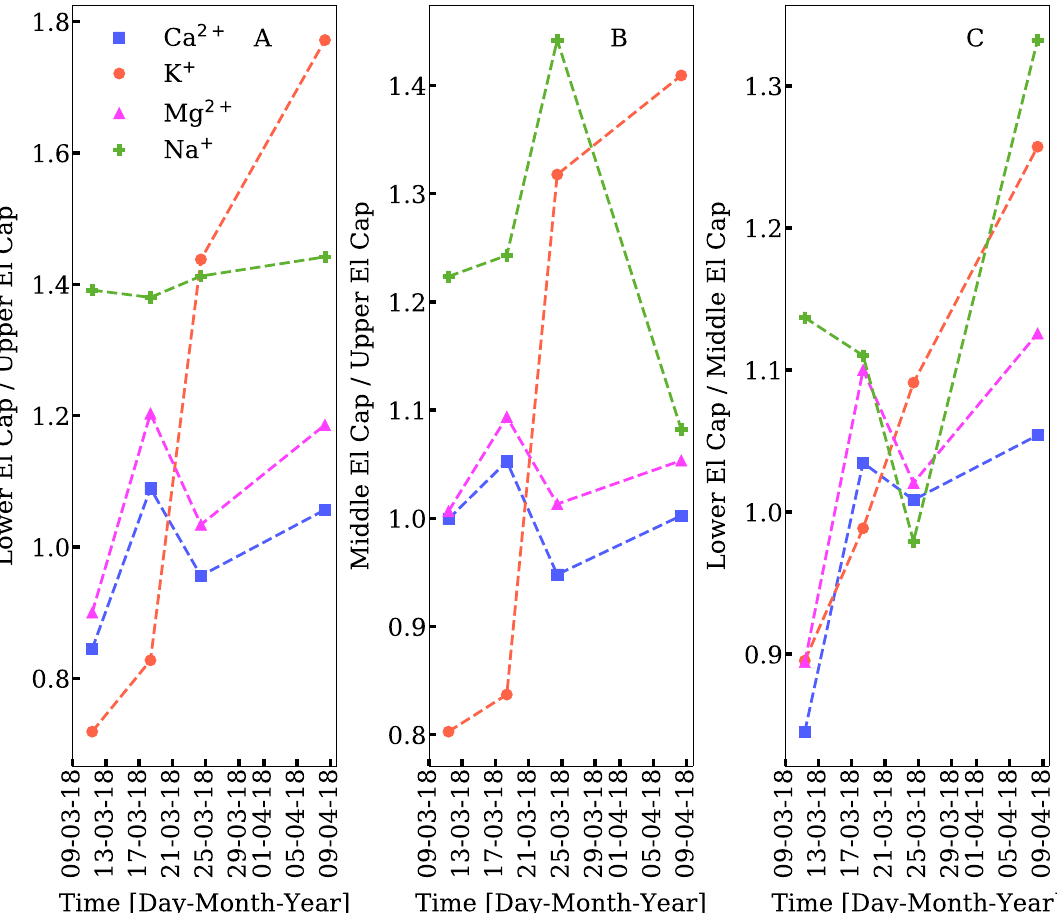
Figure 6. Comparison of major cation concentrations between downstream and upstream sites for dates (day-month-year) following the second storm (11 March 2018). Each plot illustrates same-day downstream/upstream concentration ratios for a pair of sites. The results show how concentrations of major cations changed proportionally over time (y-value > 1 implies higher concentrations downstream; <1 implies lower concentrations downstream; = 1 implies no change). ( A ) Concentrations in the Lower El Cap site compared to those of the Upper El Cap site; ( B ) concentrations in the Middle El Cap Site compared to those of the Upper El Cap site; and ( C ) concentrations in the Lower El Cap site compared to those of the Middle El Cap site. Dates follow the second major storm of the season.